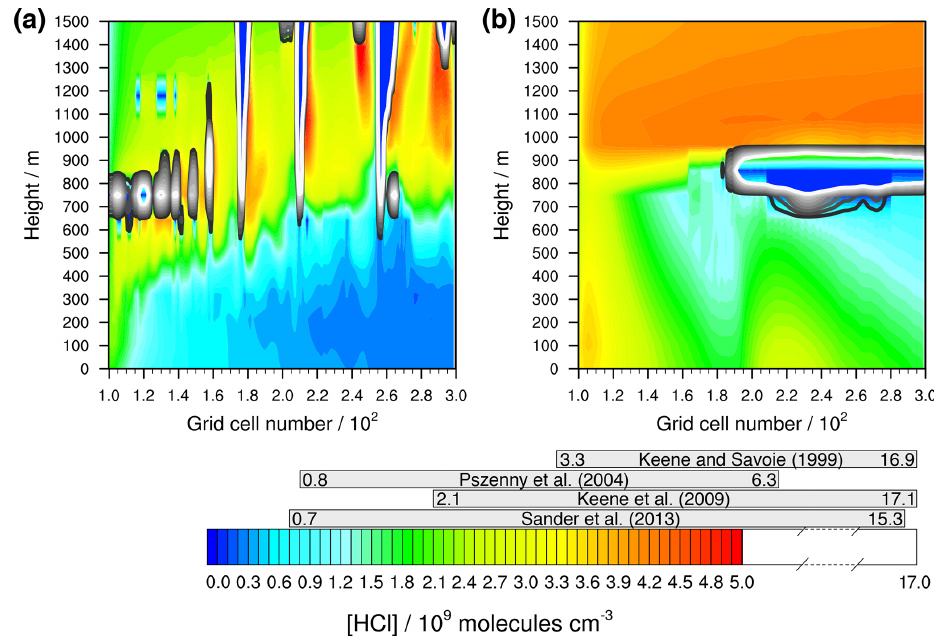
Figure 5. Simulated concentrations of HCl in the gas phase by COSMO-MUSCAT (a) in the unstable meteorological condition simulation with convective clouds and (b) in the stable meteorological condition simulation with stratiform clouds after 12h of modelling time. The x axis represents the innermost horizontal grid cells divided by 100. The grey bars represent measured values in most likely pristine marine environments (see Table S11 for further details). The black contour lines represent the simulated clouds. The black line corresponds to a LWC of 0.01gm − 3 and the white line to 0.1gm − 3 . The area framed by the white line includes LWC above 0.1gm − 3